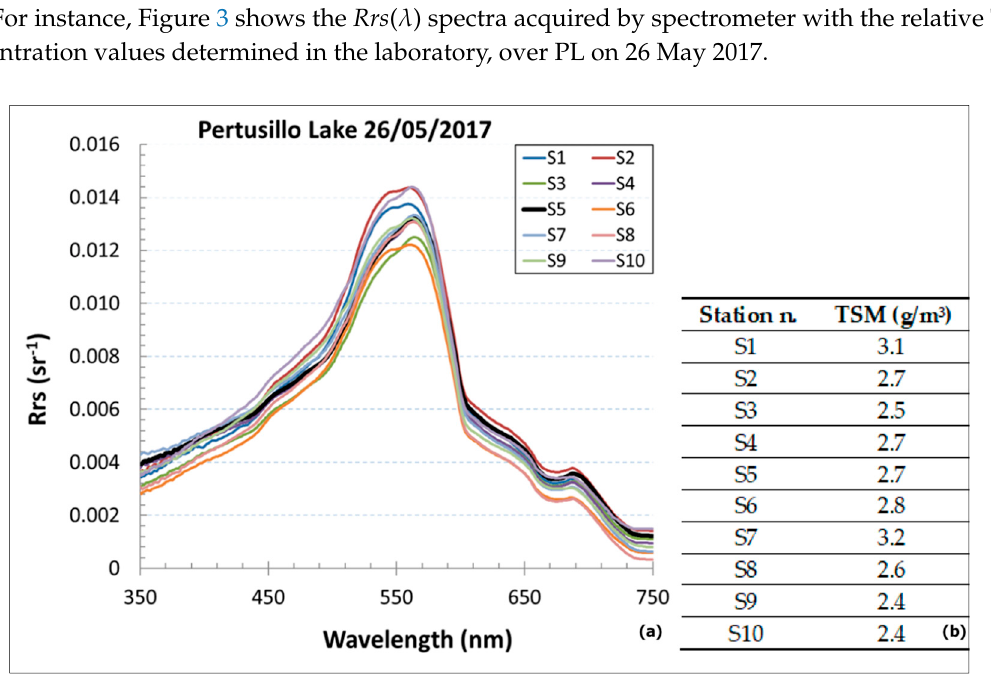
Figure 3. ( a ) Rrs spectra acquired over PL on 26 May 2017 using the ASD spectrometer, and ( b ) the relative TSM concentration values determined in laboratory.